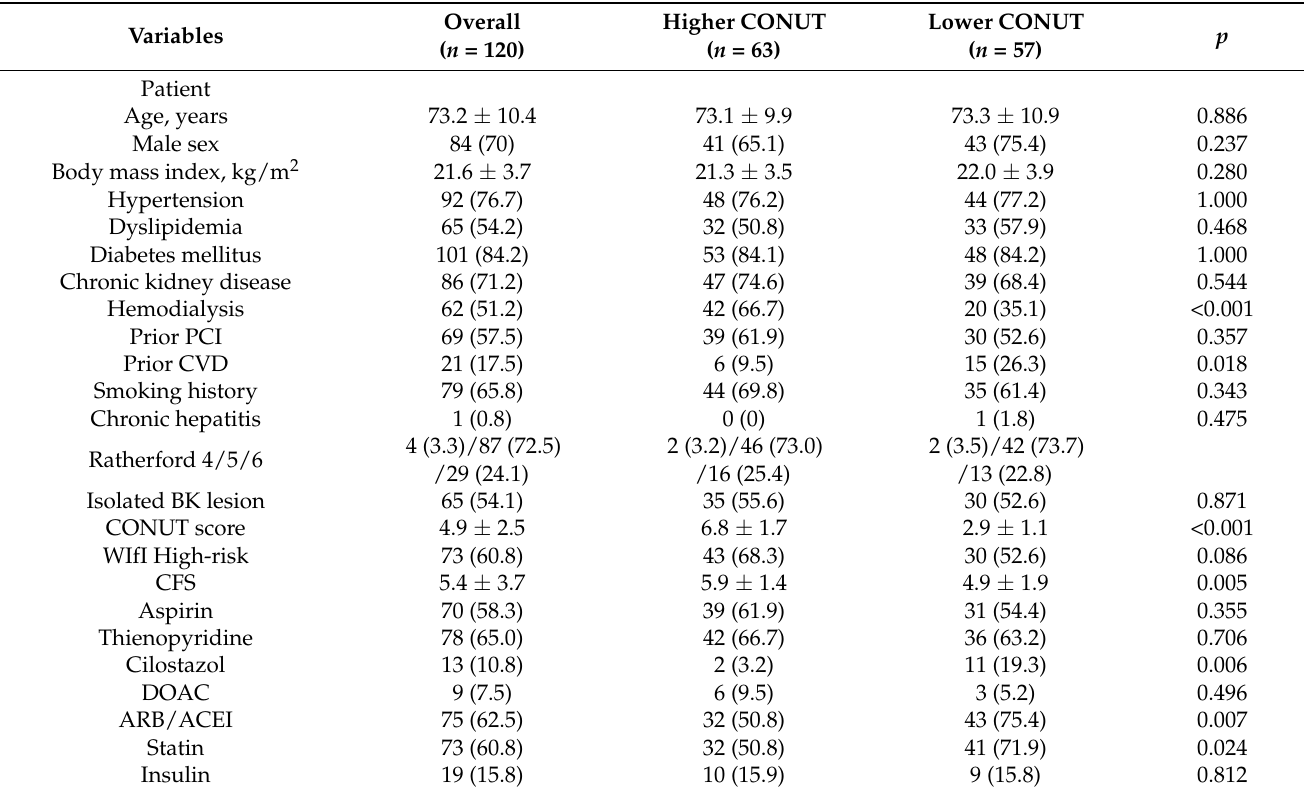
Figure 2. The distribution and the normality of controlled nutritional status (CONUT) scores were evaluated. Table 1. Baseline patient characteristics .